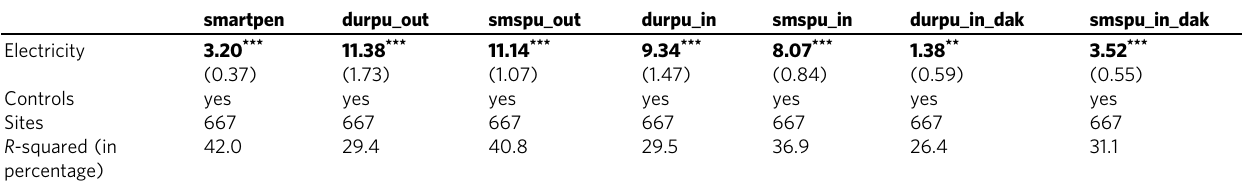
Table 2 Rural electri fi cation and mobile connectivity – OLS